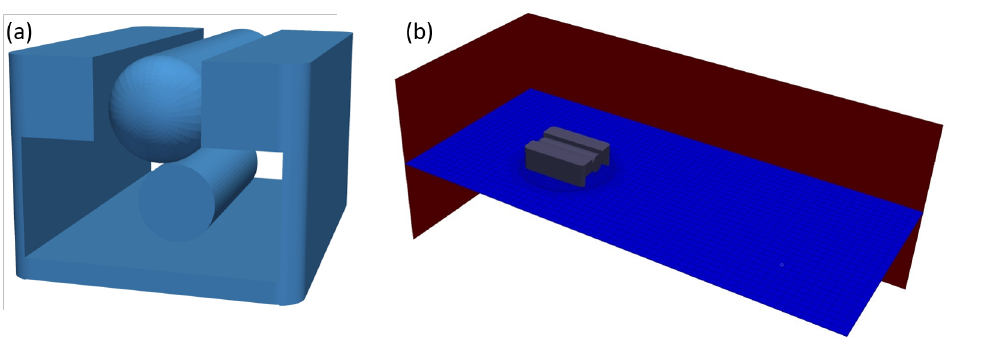
Figure 6. ( a ) The computer-aided design (CAD) model of the ROV applied in the numerical simulation created by software SolidWorks TM ; ( b ) Sketch of the computational domain with inlet and back